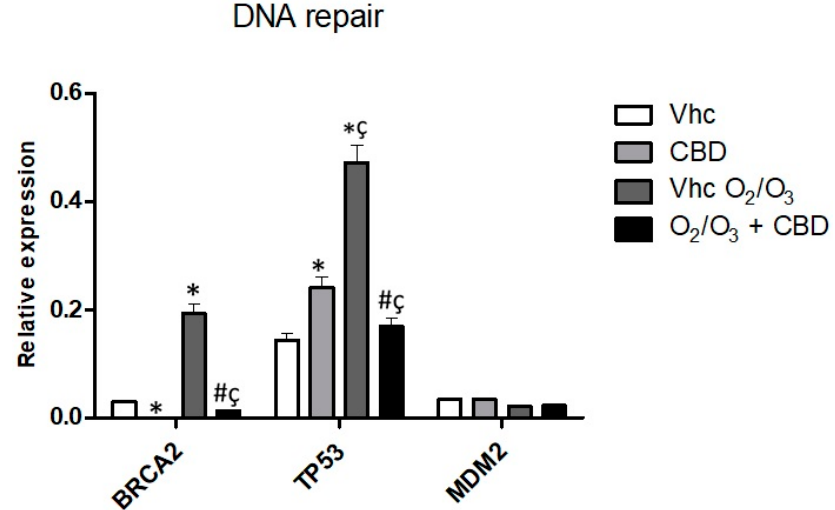
Figure 12. Modulation of DNA repair pathways in PANC-1 cell line. BRCA2 , TP53 , and MDM2 mRNA expression was evaluated by qRT-PCR in the PANC-1 cell line, treated with CBD in the presence and absence of O 2 / O 3 . Target mRNA levels were normalized for GAPDH expression. Data are expressed as fold mean ± SE. * p < 0.05 vs. Vhc, #, * p < 0.05 vs. Vhc O 2 / O 3 , ç p < 0.05 vs. CBD.